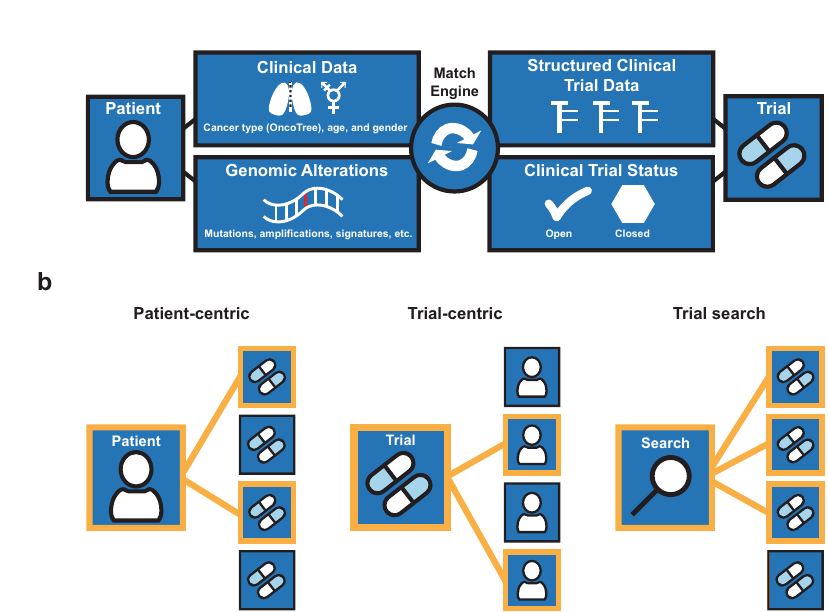
Fig. 1 MatchMiner overview of data fl ow and modes of use. a Data inputs from patients and trials are utilized by the MatchEngine to match patients to trials. b Shown are the 3 modes of matching patients to trials: patient-centric, trial-centric, and trial search. Orange lines indicate patient-trial